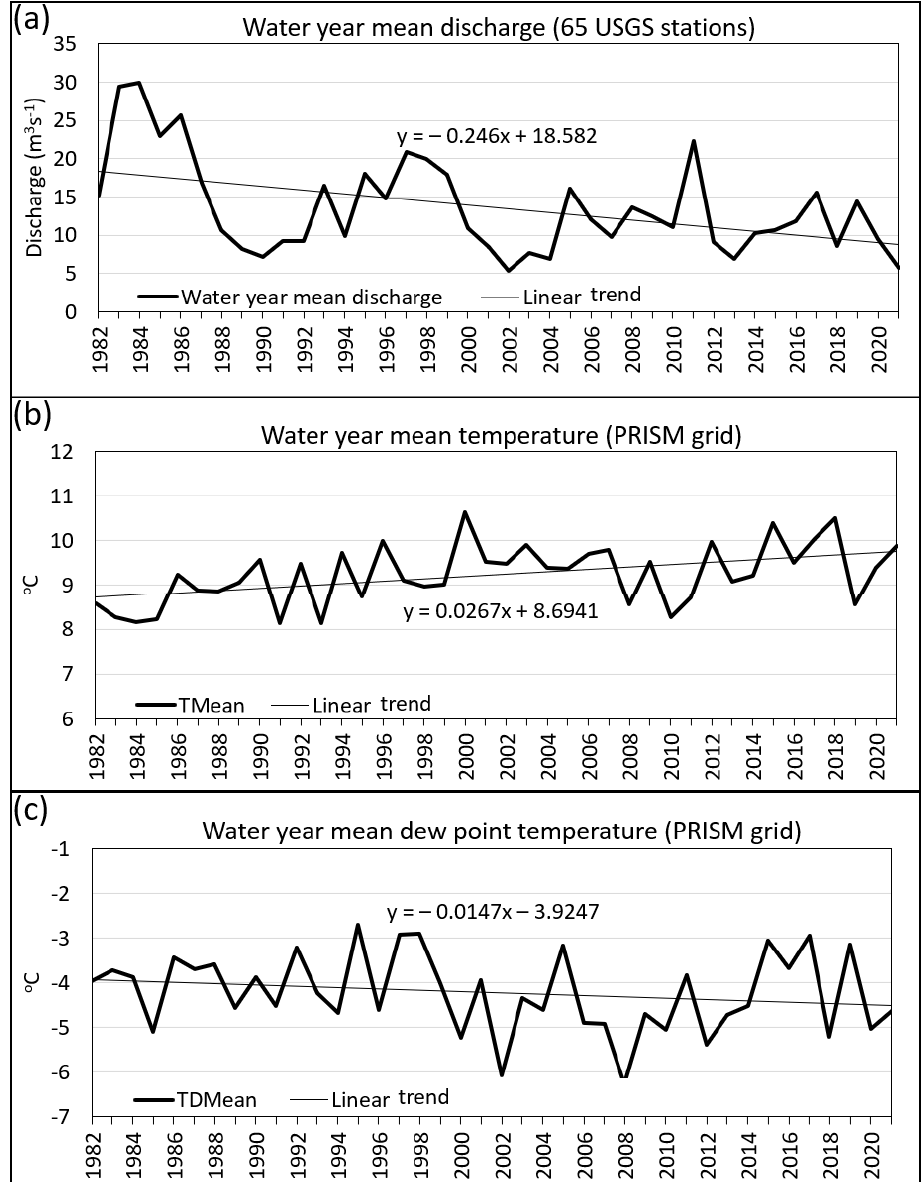
Figure 2. Time series with linear trends in annual mean water year data from water years 1982 to 2021 for ( a ) stream discharge at the 65 USGS stations used in this study; ( b ) PRISM water year mean air temperature and trend for Utah; and ( c ) PRISM water year mean dewpoint temperature and trend for